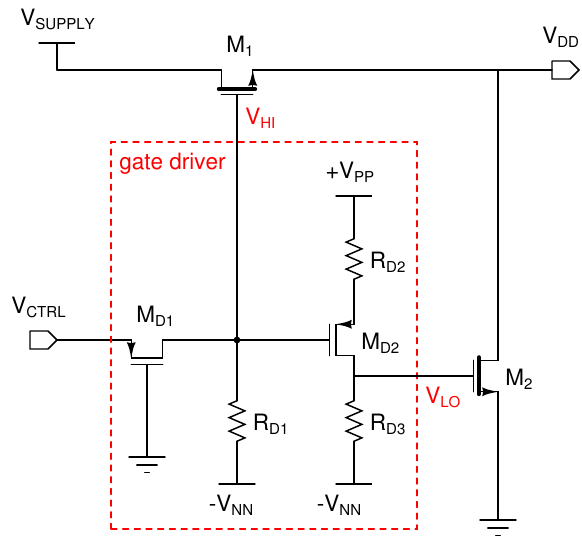
Figure 3. Schematic of the hybrid MoS 2 -FET power switching